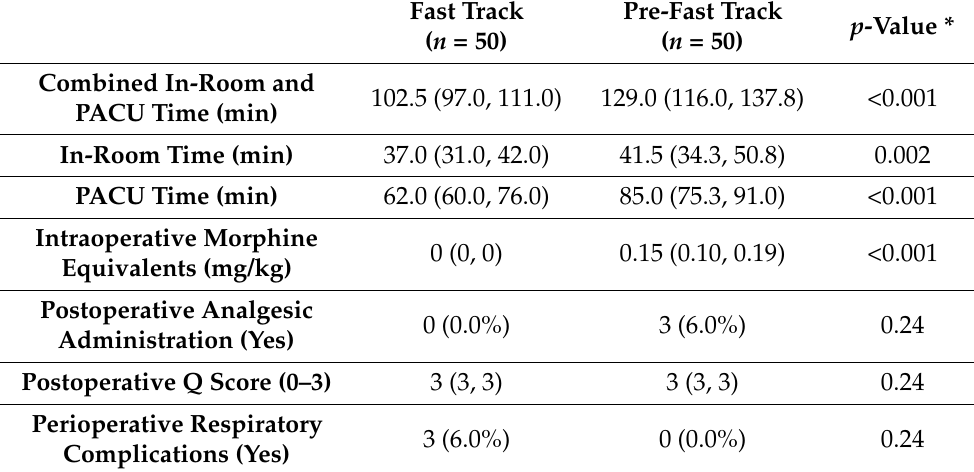
Table 3. Key Perioperative